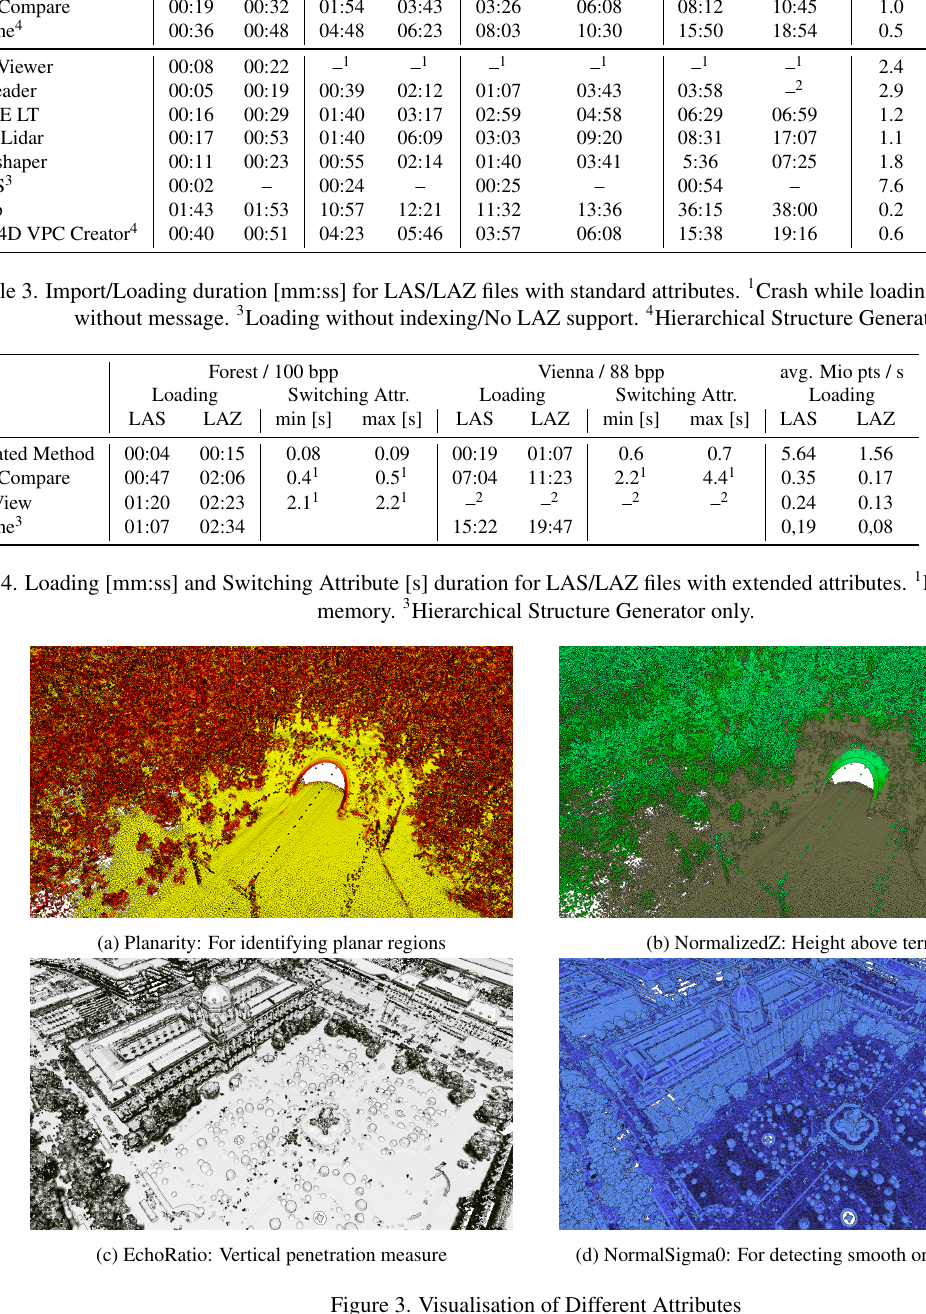
Figure 3. Visualisation of Different